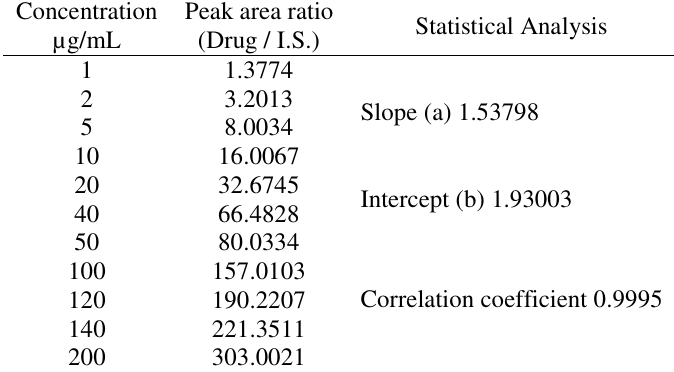
Table 1. Linearity range of